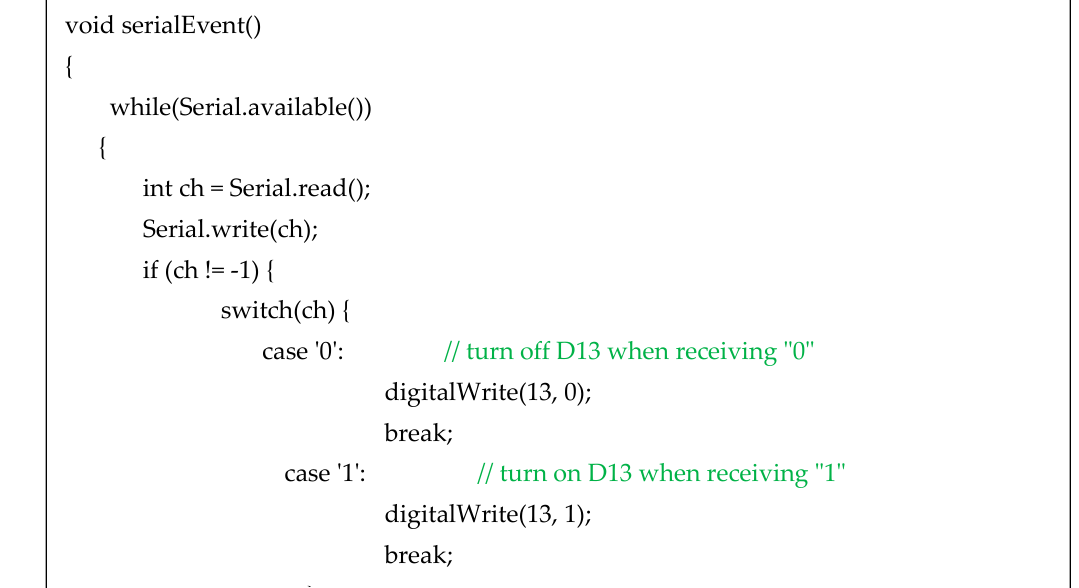
Figure 10. The blinking operation of the LED lamp.